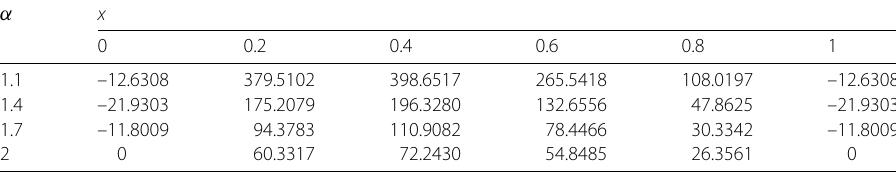
Table 1 Steady-state solutions to fractional order α ∈ (1,2] varying x ∈ [0,1] using CFDO α